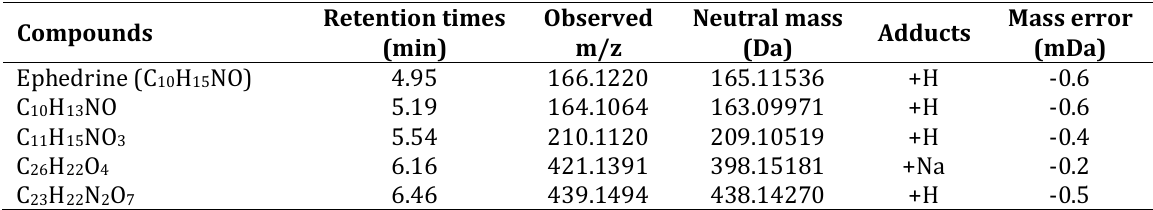
Table III. Detected compounds of fraction 4.7 using LCMS/MS analysis